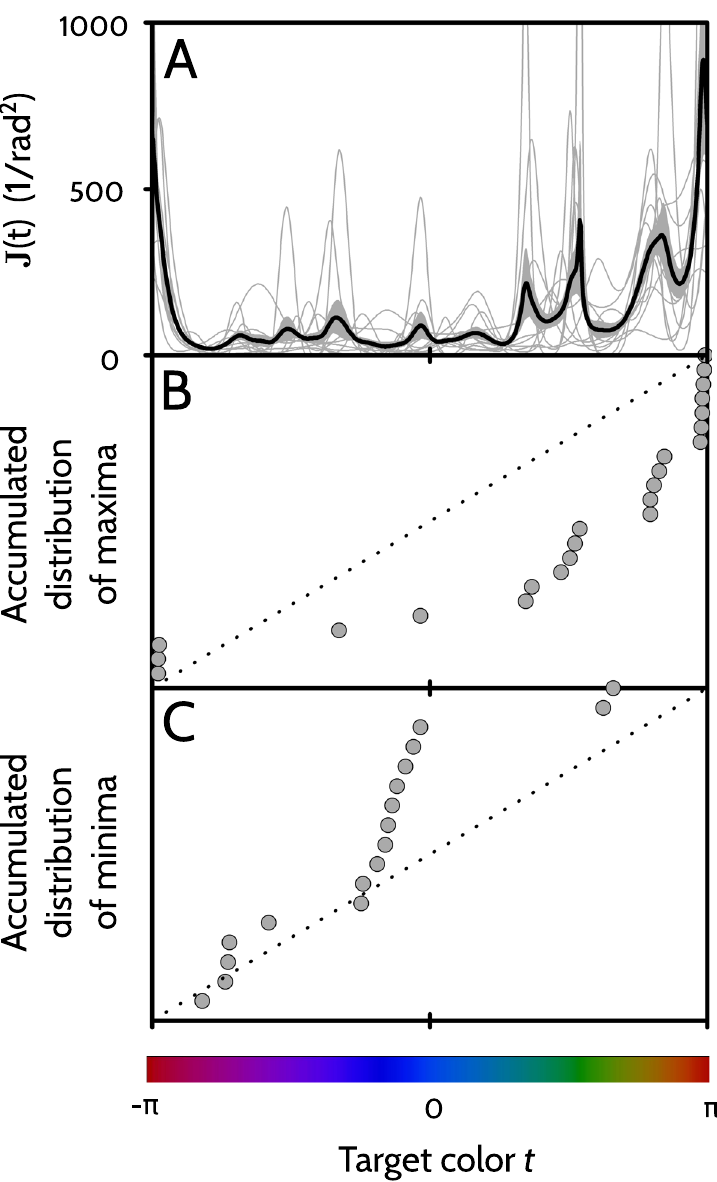
Fig 7. Amount of Fisher information along the locus of sampled colors. A: Thick line: Sample average of the amount of Fisher information obtained by the individual players. Gray area: Region of values contained in h J ( t ) i ± standard error of the sample mean. Thin lines: individual curves J ( t ) for each of the 11 players. B: Data points: Empirical cumulative distribution function of the set of relevant maxima of J ( t ) obtained from the 11 players. Dotted line: Accumulated distribution expected for a process with uniform probability density. C: Data points: Empirical cumulative distribution function of the set of relevant maxima of 1/ J ( t ) obtained from the 11 players. Dotted line: Same as in B. In B and C, the vertical axis extends from 0 to